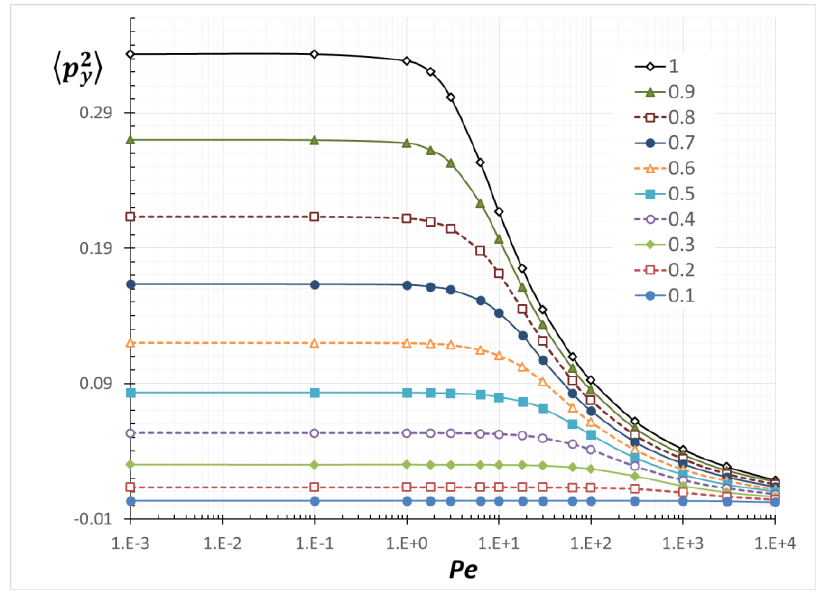
Figure 14. Average orientation moment < p y2 > as a function of Pe with various α / a .